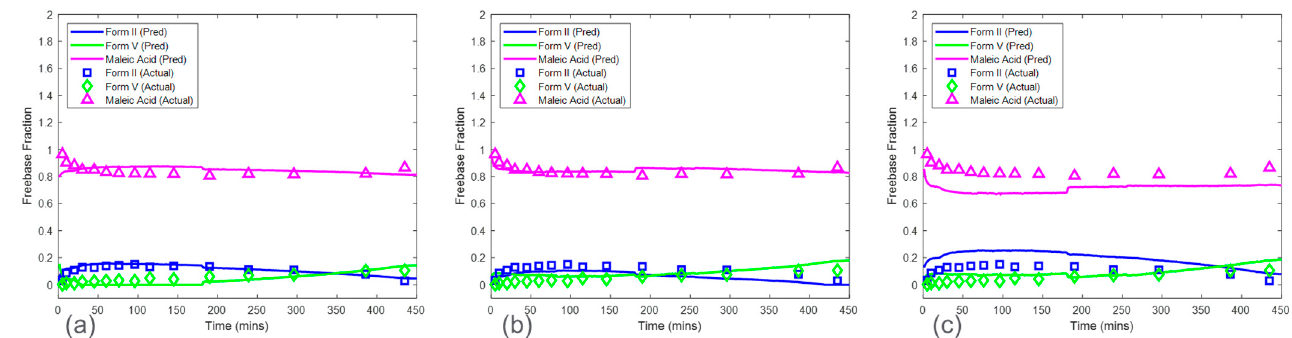
Figure 10. Model prediction on maleate salt experiments using the calibration without concentration procedure: 50 mg/mL (model set 1) ( a ), 25 mg/mL (model set 2) ( b ), and 12.5 mg/mL (model set 3) ( c ) solid concentrations. Note the relative standard deviation of XRPD reference values was ap- proximately 4%.